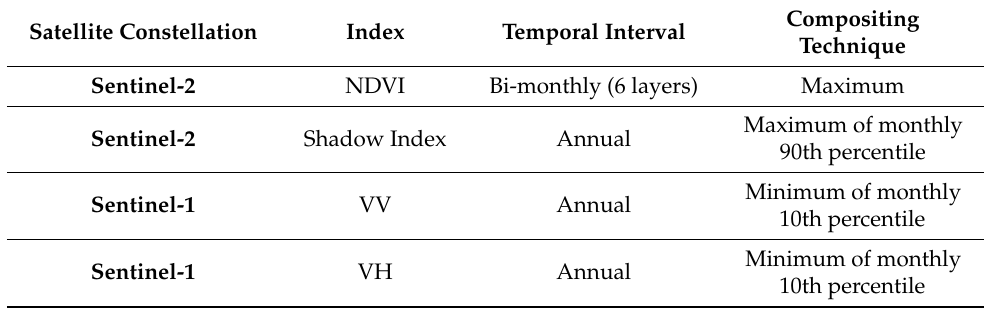
Figure 4. Example of temporal profiles (in Db) for the year 2018 in VV and VH polarization for different land cover classes. Table 1. The Sentinel-1 and Sentinel-2 layers selected for the